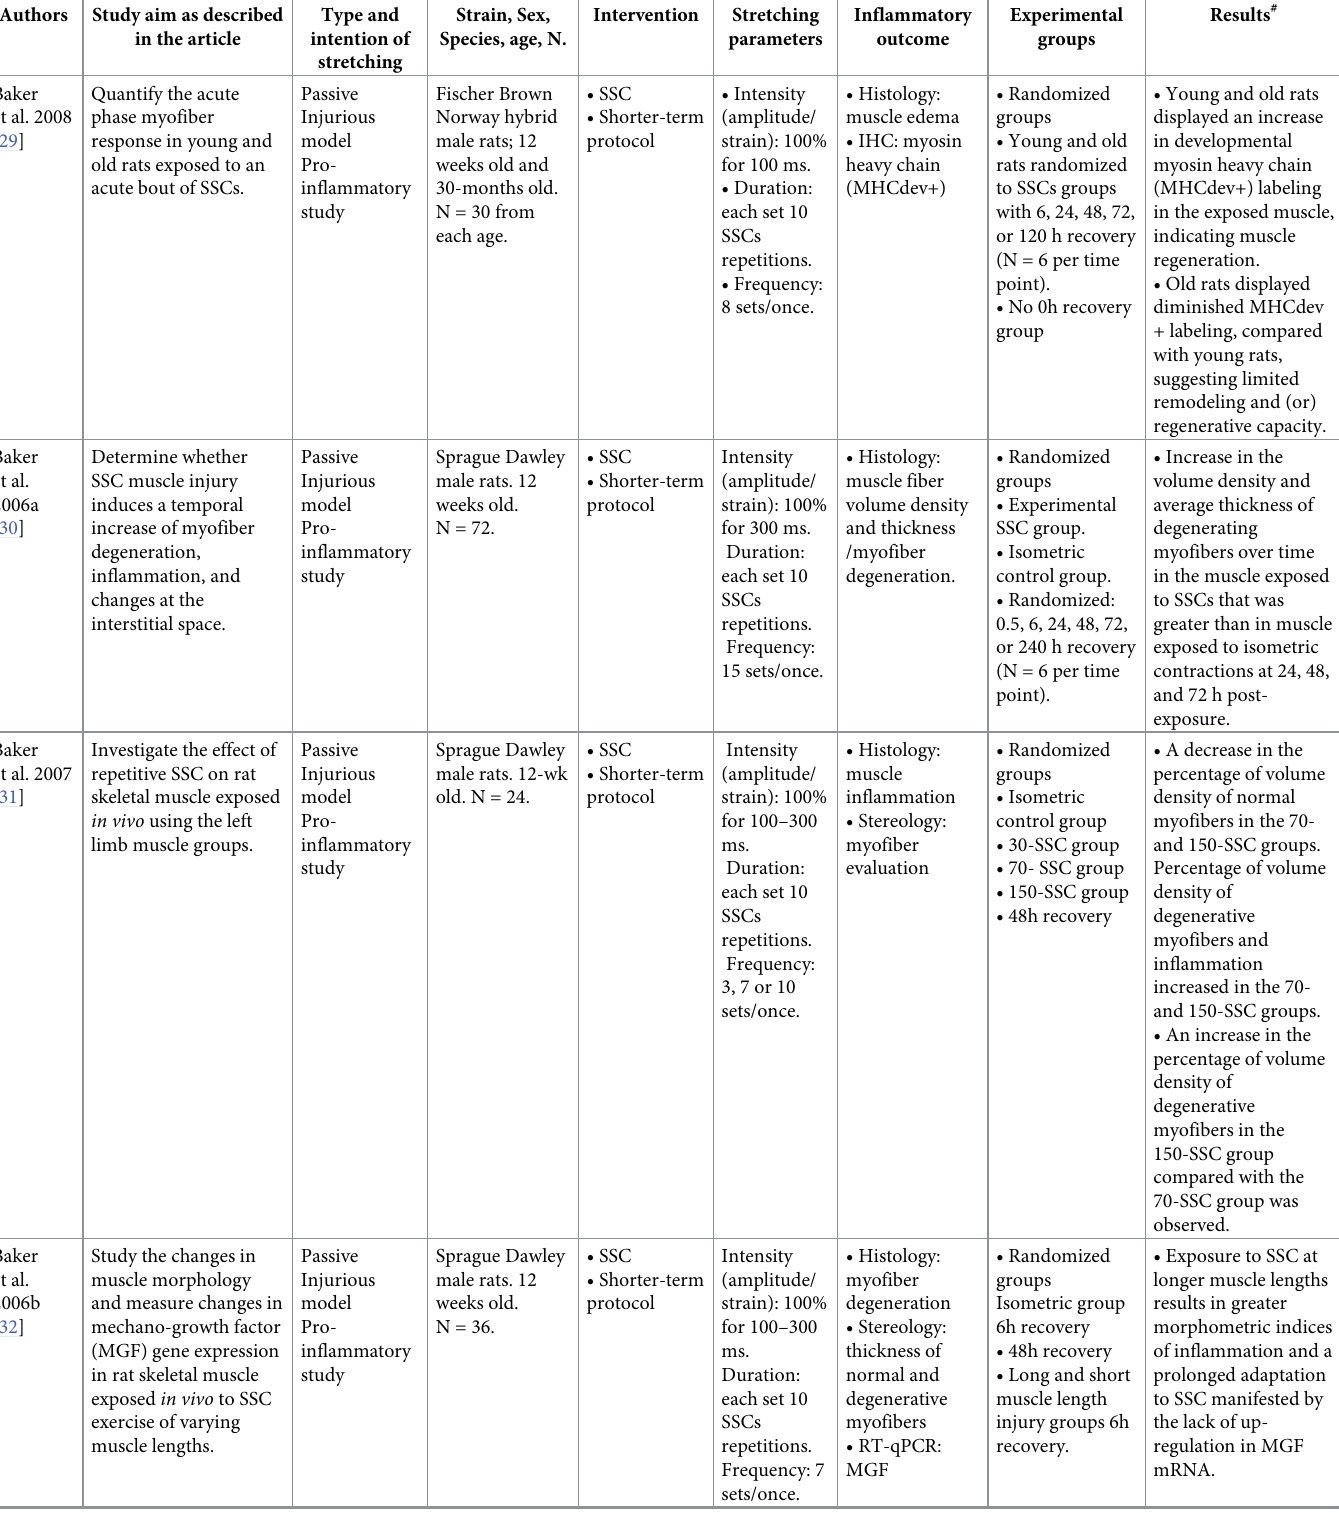
Table 3. Summary of effects of muscle stretching on inflammatory markers in animal